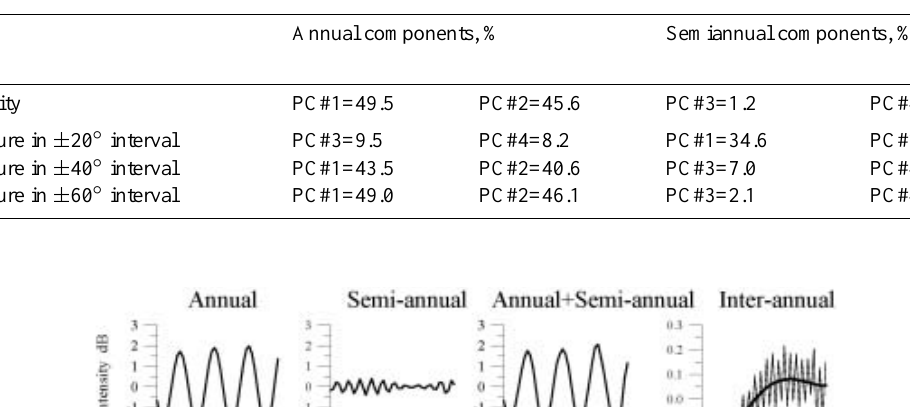
Table 1. Annual and semiannual components extracted from the data series by the PCA processing.